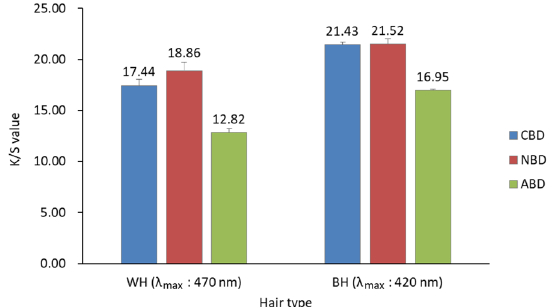
Fig. 2 Color strength (K/S) of white hair (WH) and bleached hair (BH) dyed with the three types of basic hair dyes. CBD Cationic basic hair dye, NBD Nonionic basic hair dye, ABD Anionic basic hair